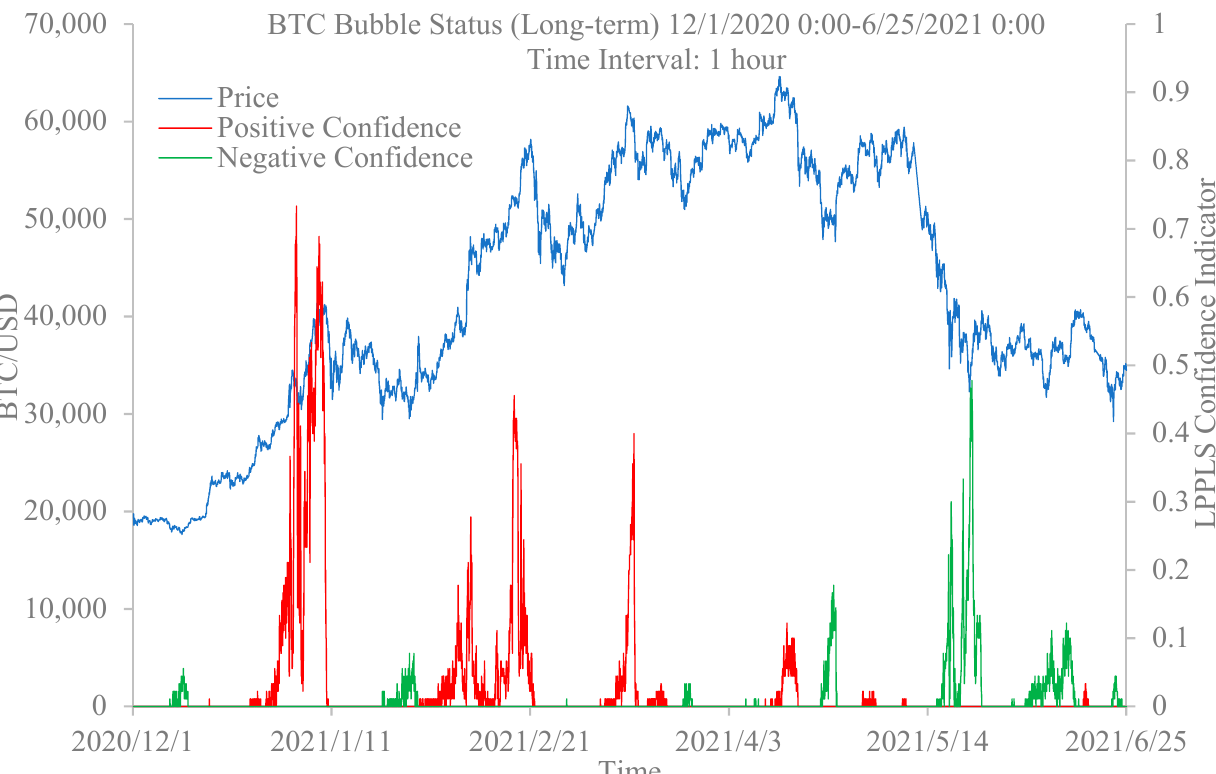
Figure 10. Long-term hourly LPPLS confidence indicator for positive bubbles is shown in red and negative bubbles in green (right scale), along with the Bitcoin price in blue (left scale) from 12/1/2020–6/25/2021.